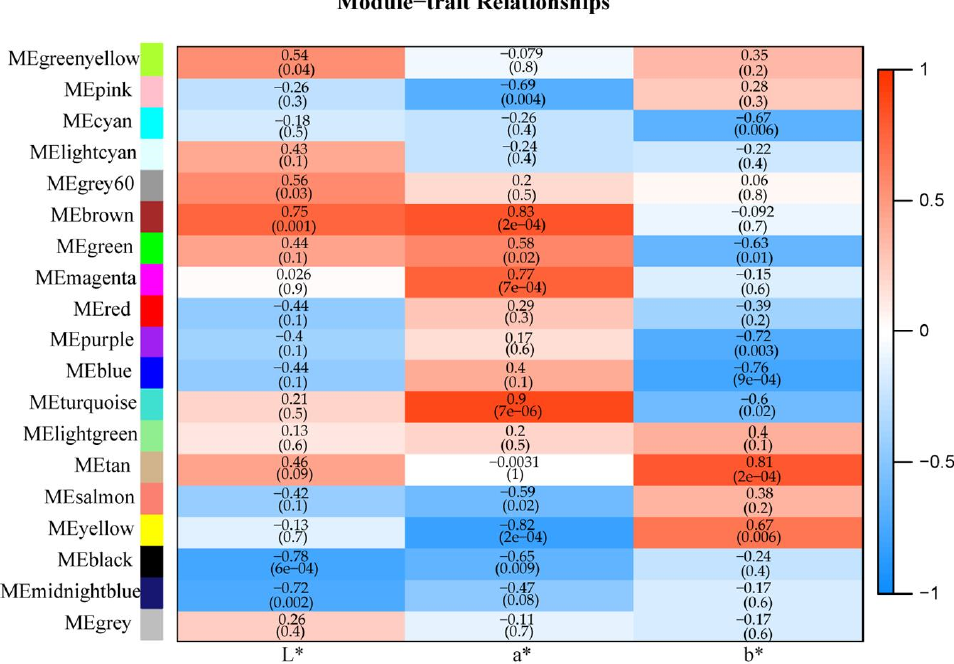
Figure 9. Correlation analysis of WGCNA module with chromatic aberration. Each column corresponds to L*, a*, and b* values, and each row represents a module. Chromatic aberration values and module correlation coefficients are shown within each module. p- values are shown in parentheses.